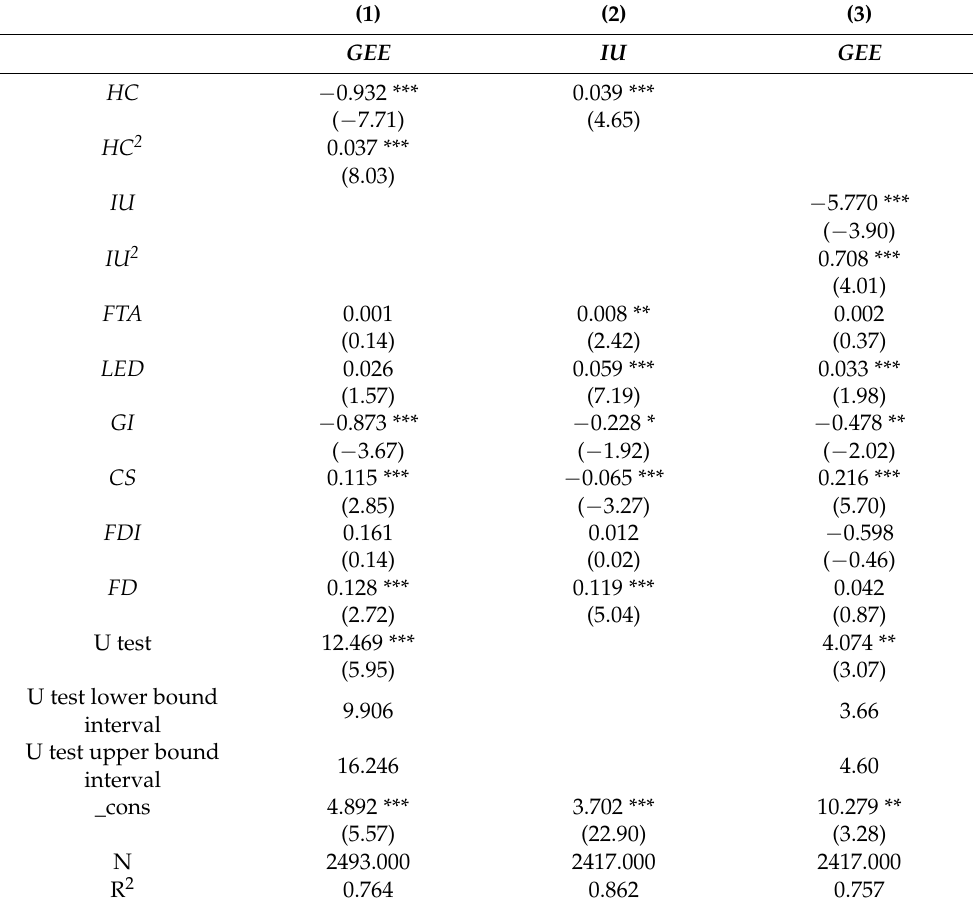
Table 5. Empirical results of the relationship between HC, industrial upgrading and